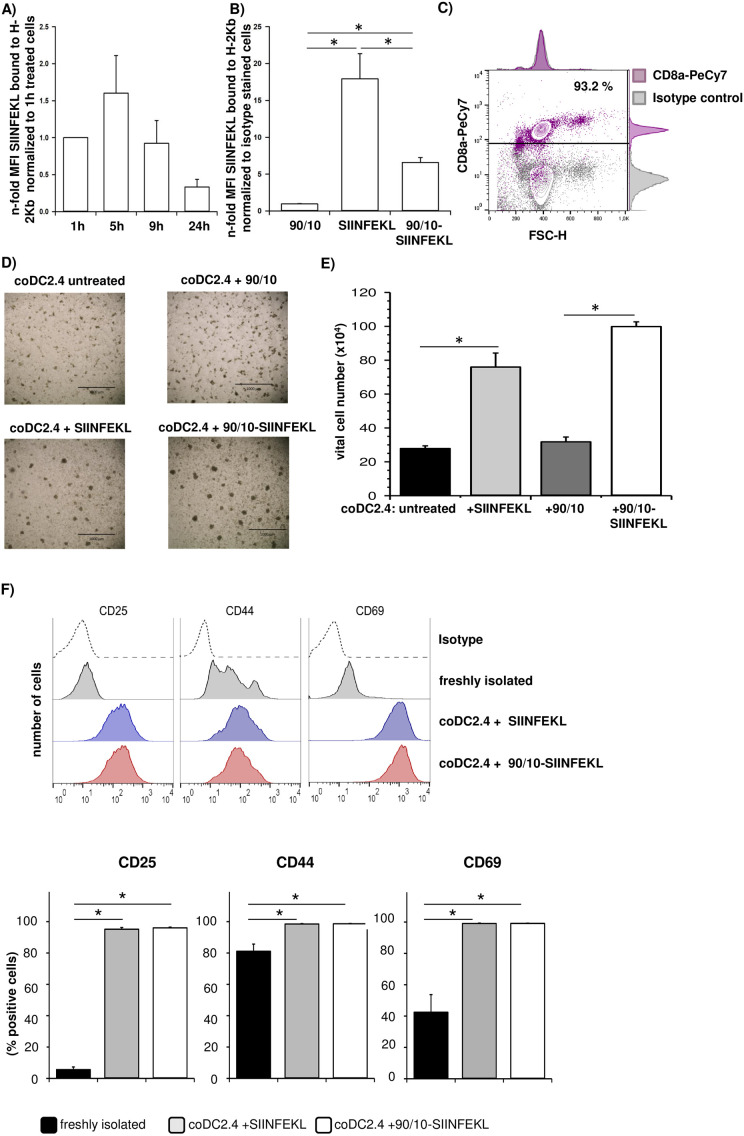
Uptake of SIINFEKL loaded CNPs by DCs efficiently stimulates CD8+ OT-1 T cell activation and expansion.A) DC2.4 cells were either left untreated or treated with 100 μg/ml SIINFEKL-loaded 90/10-CNPs for 1, 5, 9 and 24 hours or B) DC2.4 cells were treated with 100 μg/ml empty (90/10) or SIINFEKL-loaded 90/10-CNPs or 1 μg/ml SIINFEKL for 5 hours. SIINFEKL bound to H-2Kb molecules was determined by flow cytometric analysis. Median fluorescence intensity (MFI) ratio was calculated by normalizing MFI of staining with anti-SIINFEKL-H-2Kb antibody to MFI detected in staining with its respective isotype control (n-fold MFI). In A) MFI ratio of treated cells was also normalized to MFI of 1h treated cells and expressed as n-fold MFI of untreated cells. C) CD8+ OT-1 T lymphocytes were isolated from spleens of OT-1 mice. Purity of CD8+ OT-1 T cells was determined after negative MACS selection by CD8 staining and flow cytometric analysis. One representative dot blot is shown. D-F) DC2.4 cells were either left untreated or were treated with 100 μg/ml empty (90/10) or 100 μg/ml SIINFEKL-loaded 90/10-CNPs or 1 μg/ml SIINFEKL for 5 hours. Afterwards, differentially treated DC2.4 cells were cocultured with CD8+ OT-1 T lymphocytes for 72 hours. D) Representative phase contrast images of CD8+ OT-1 T cells cocultured with DC2.4 cells that had been either left untreated or subjected to the indicated treatment. Scale bar = 1000 μm. E) Numbers of vital CD8+ OT-1 T lymphocytes were determined after the indicated coculture setting. Data are presented as mean + SEM of three independent experiments. F) Flow cytometric analysis of T cell activation by staining of cell surface CD25, CD44 and CD69 of CD8+ OT-1 T cells directly after isolation and after coculture with DC.24 cells that had been pretreated with SIINFEKL or 90/10-SIINFEKL CNPs. Representative histograms from one out of 3 independent experiments are shown and bar charts present the % of CD8+ OT-1 T cells positive for cell surface expression of CD25, CD44 and CD69, respectively. Data are presented as mean +SEM of three independent experiments. *p < 0.05.